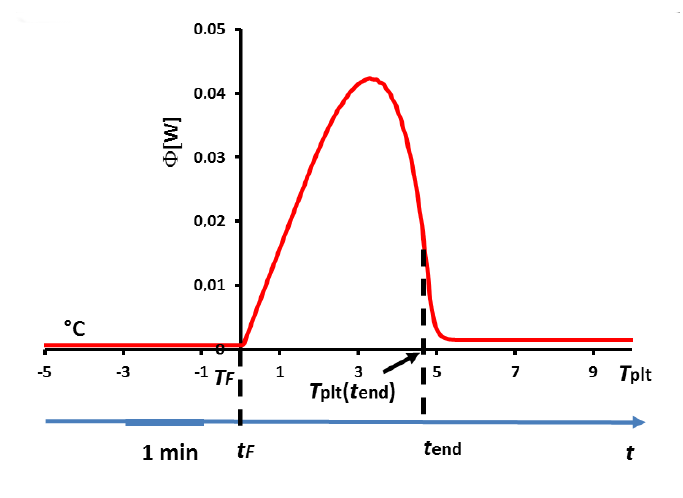
Figure 8. Example of a thermogram of the melting of 11.35 mg of pure ice at 2